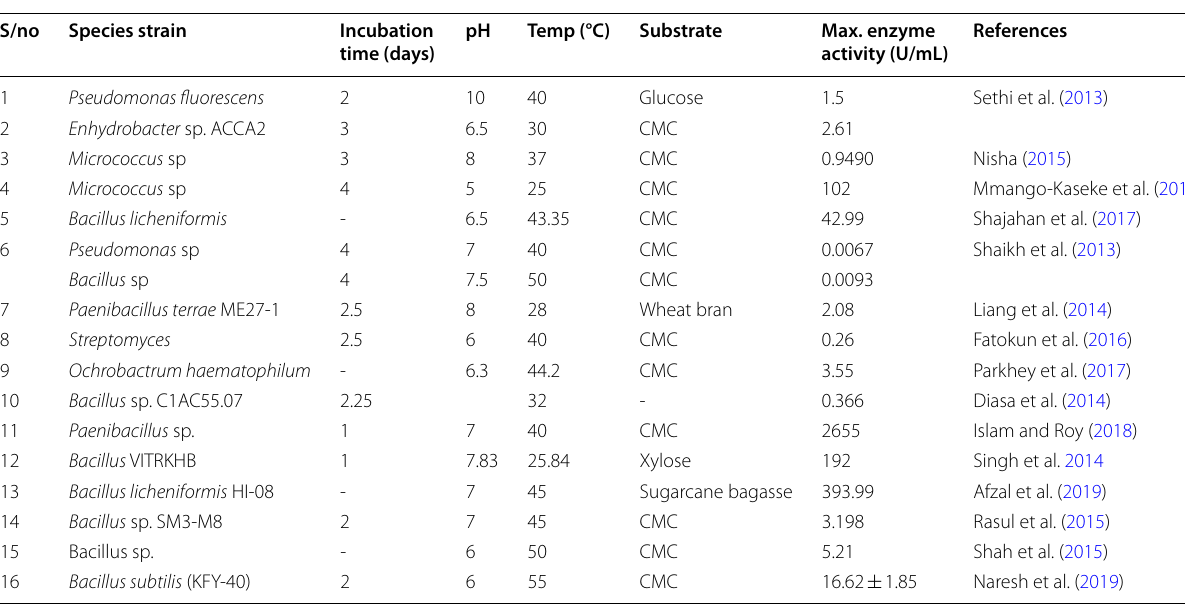
Table 1 Some cellulase-producing bacterial species